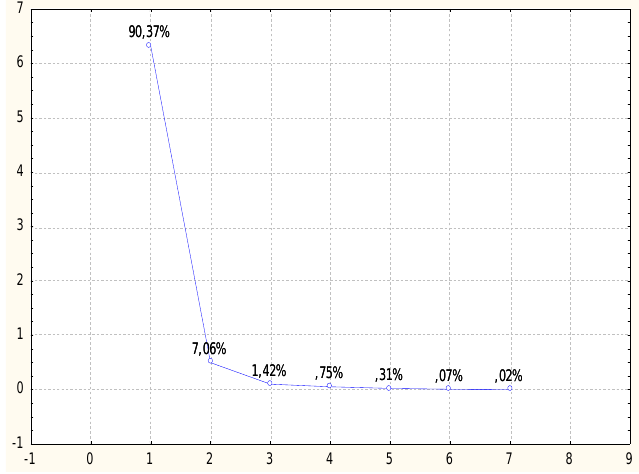
Figure 2. Screen for variables describing enzymatic hydrolysis process.